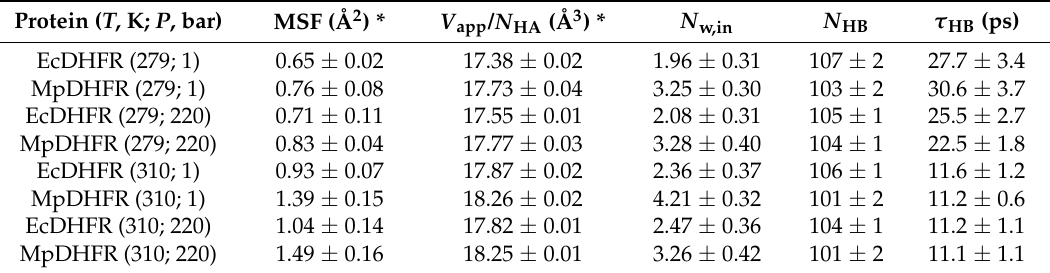
Table 1. Average properties for EcDHFR and MpDHFR in the molecular dynamics (MD) simulations. Protein ( T , K; P , bar) MSF (Å 2 ) * V app /N HA (Å 3 ) * N w,in N HB τ HB (ps) EcDHFR (279; 1)